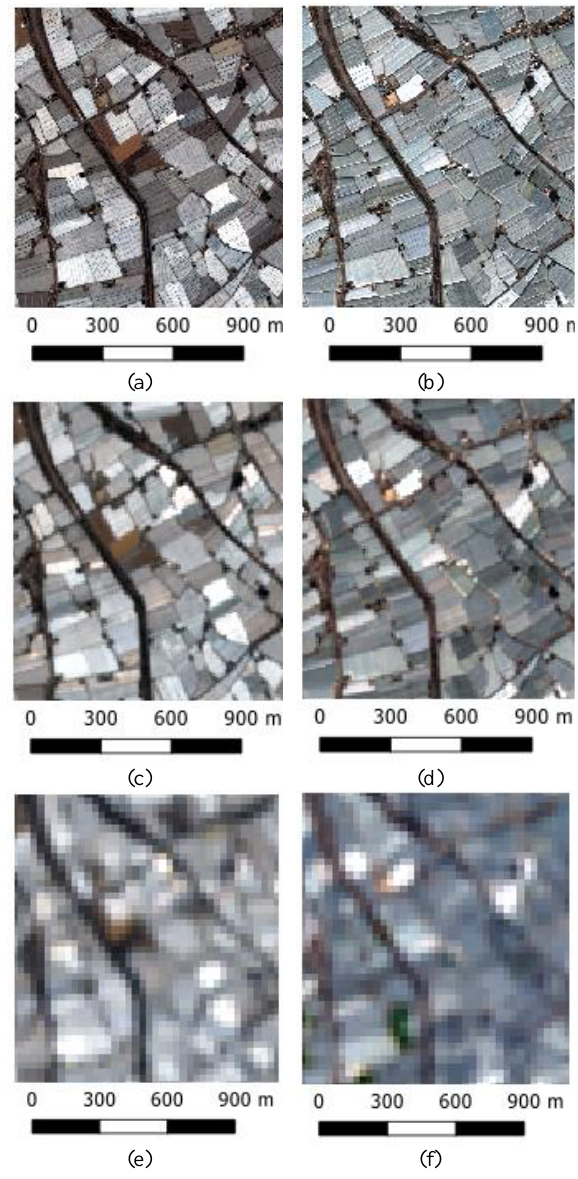
Figure 2 . Detailed view (RGB) of six of the images used in this work: (a) WV3 3.7 m GSD, July 11; (b) WV3 3.7 m